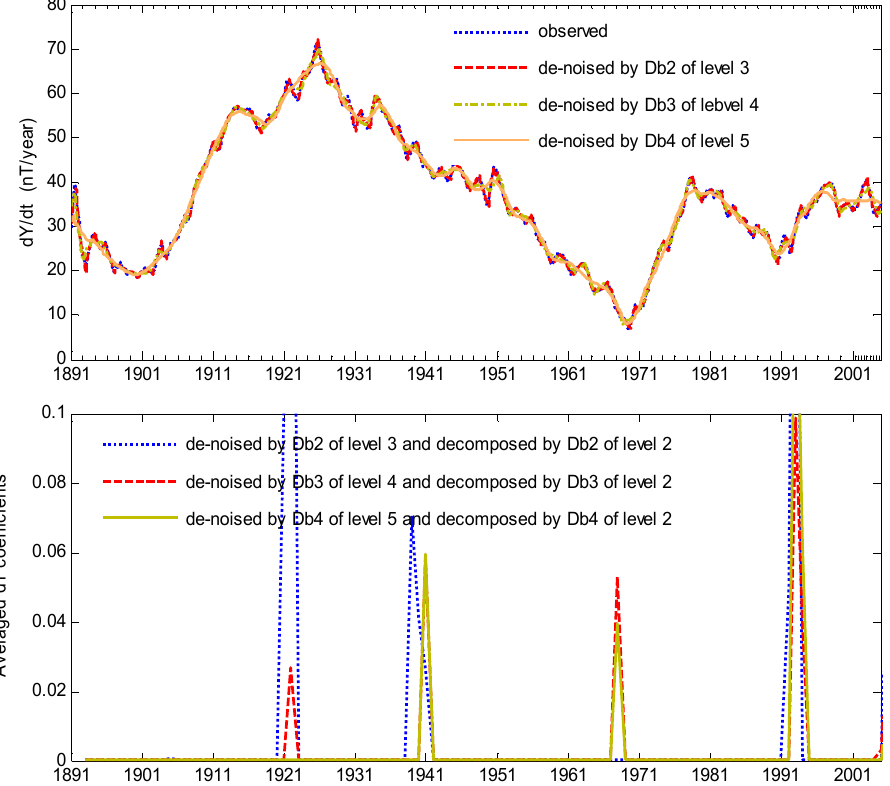
Fig. 8. De-noised SV Y signal of NGK (up) and the respective values of averaged ( rms ) d 1 coefficients (down). The unit of d 1 coefficients are in nT/year.